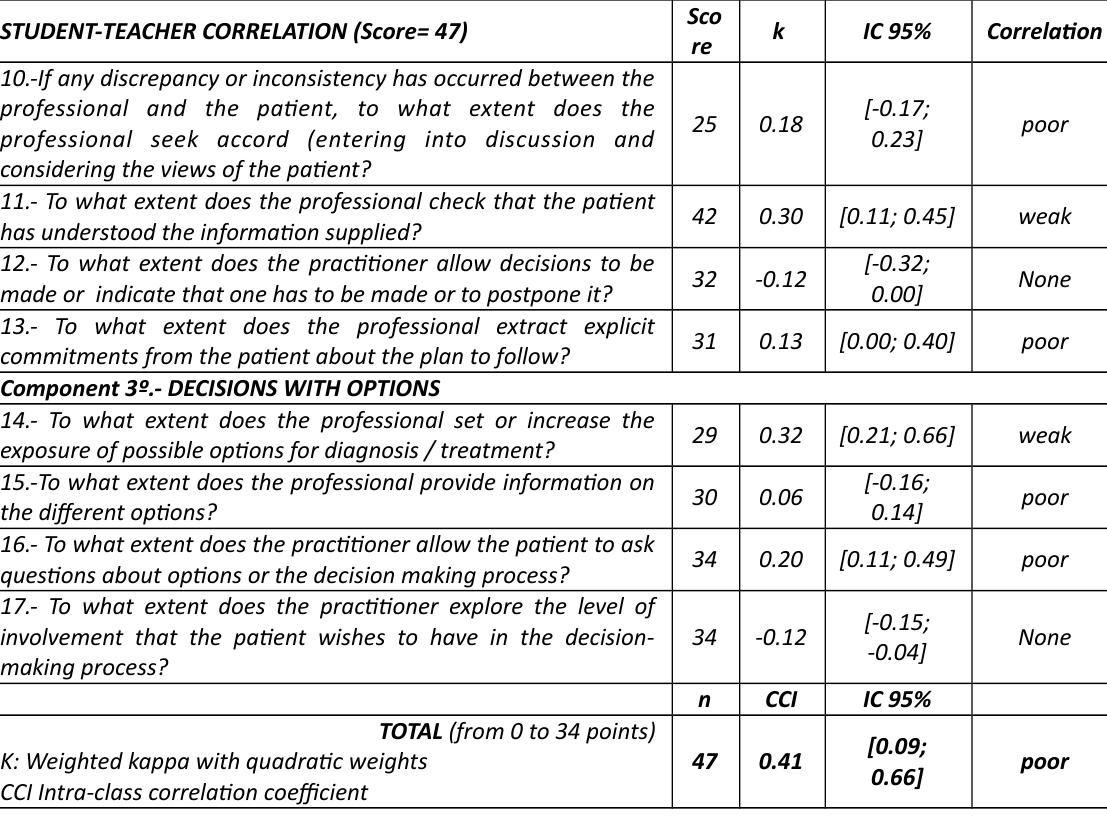
Table 3. Correlaton between self-assessment of students and teacher assessment through CICCA-D questonnaire of the video recording